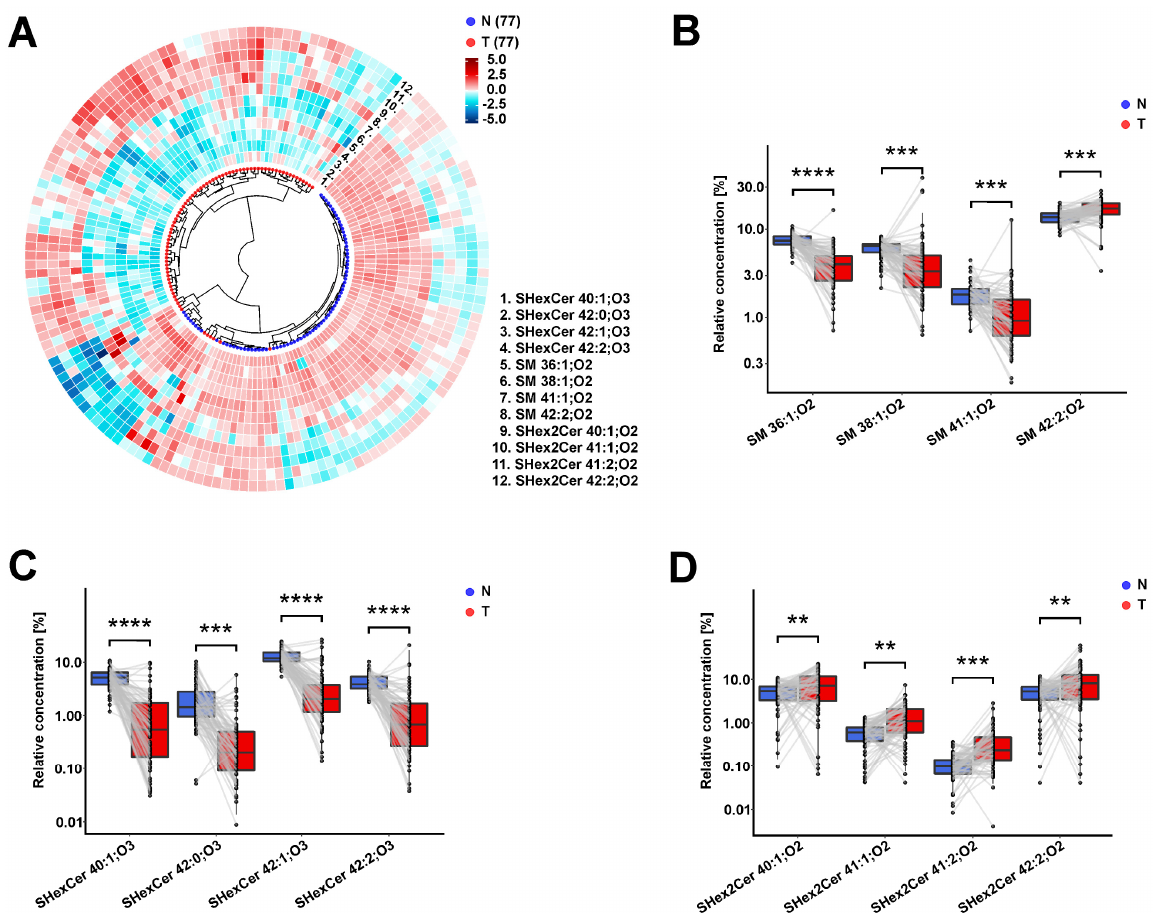
Figure 4. Important dysregulations observed in studied tissue samples: ( A ) Circular dendrogram with heat map calculated based on the concentrations of the four most significant SM, four most significant SHexCer, and four most significant SHex2Cer species, demonstrating classification of tumor (red) and nonneoplastic (blue) tissue samples of 77 RCC patients. Data were log-transformed and Pareto scaled, then the Euclidean distances were calculated and Ward’s clustering method was selected. The heatmap was generated using z-score scaling. ( B – D ) Paired box plots of concentrations of four most significant SHexCer, four most significant SHex2Cer, and four most significant SM in tumor tissue and nonneoplastic tissue samples of RCC patients. The importance marked above box plots includes fold change, effect size, and FDR from the Wilcoxon signed-rank test: **** very large, *** large, ** medium (see detailed explanation in Supplementary Data S2J).